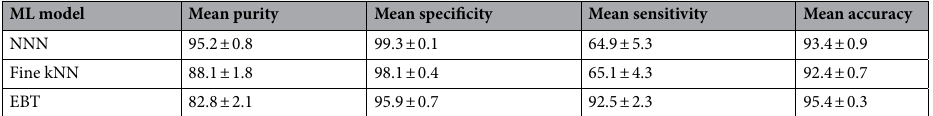
Table 2. Average performance (± standard deviation) of three ML classification models. All models were trained and tested based on the described pseudocode (see Supplementary Fig. S1) with the only variation being the classification model